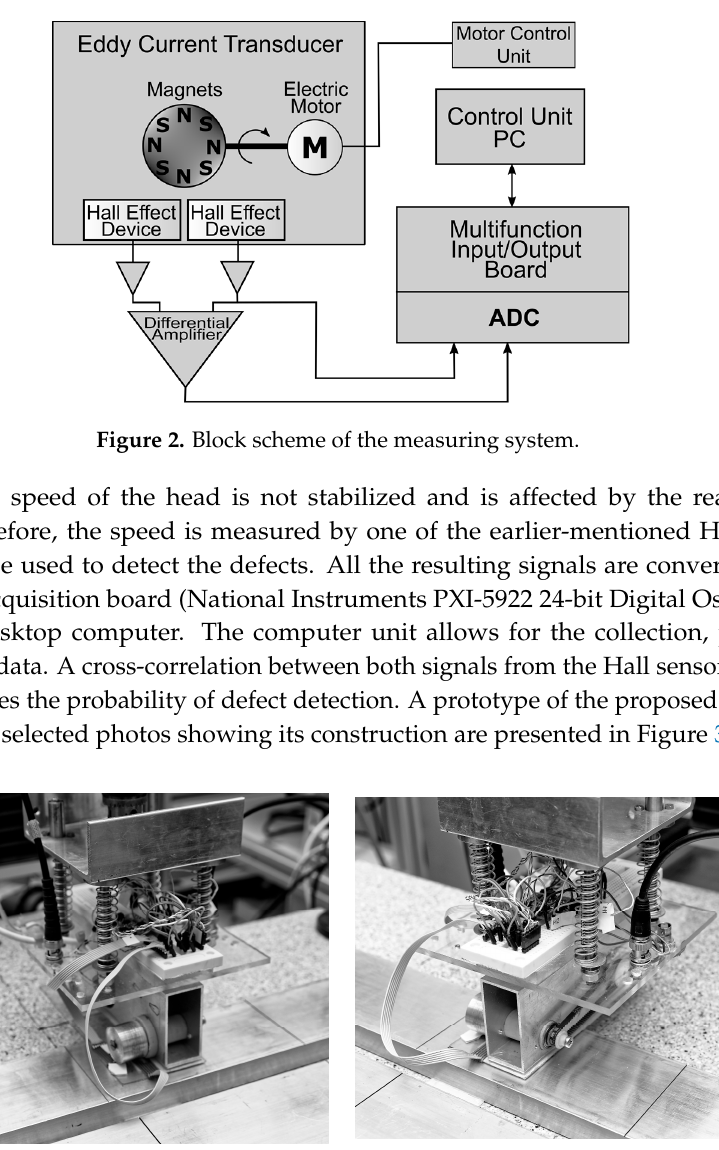
Figure 3. Prototype of the eddy current transducer with rotating magnets.